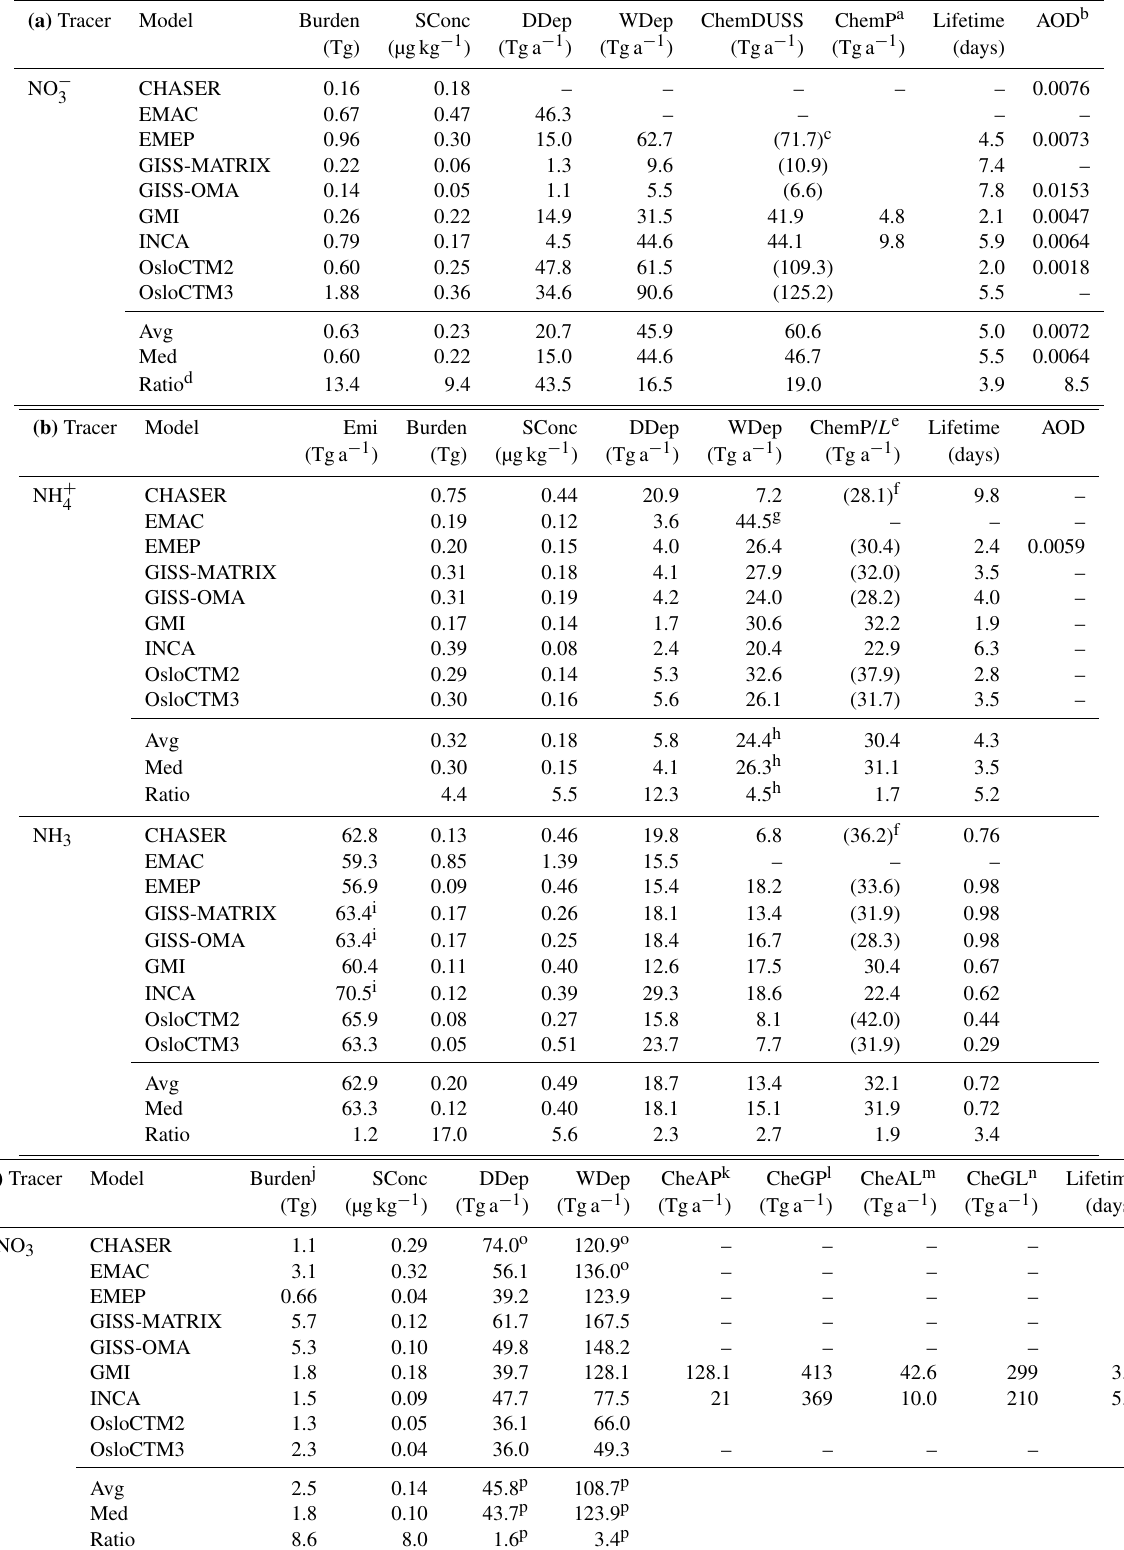
Table 4. (a) NO − global budget for each model. (b) NH 3 and NH + 3 (d) SO 2 − global budget for each model. “Avg” indicates the average values; “med” indicates the median values; “emi” indicates emissions. 4